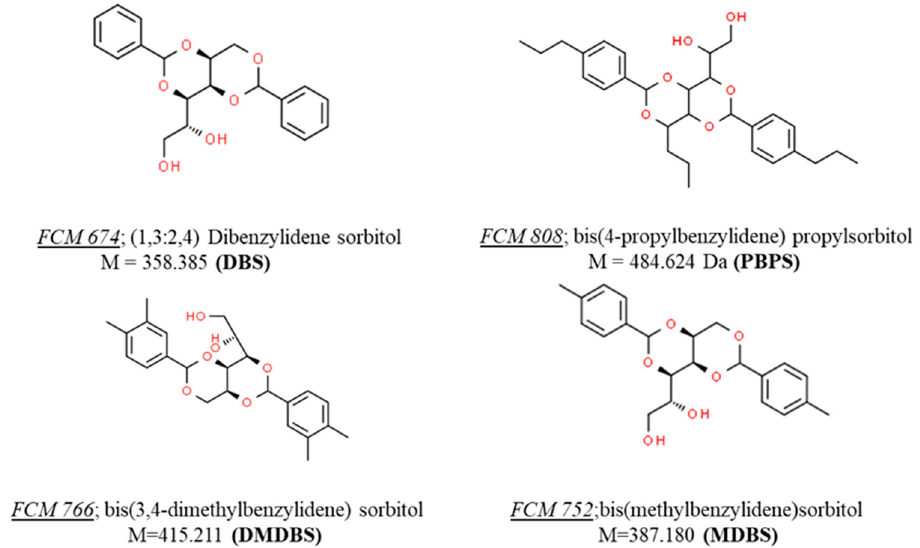
Figure 1. Basic chemical structure of sorbitol-based NCAs highlighted different side chains and their systematic names.